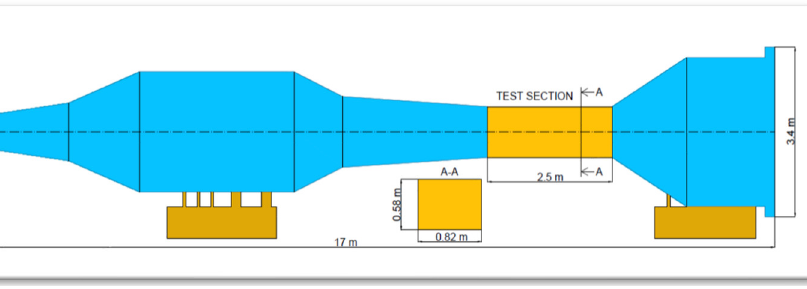
Figure 3. Sketch of the wind tunnel used.